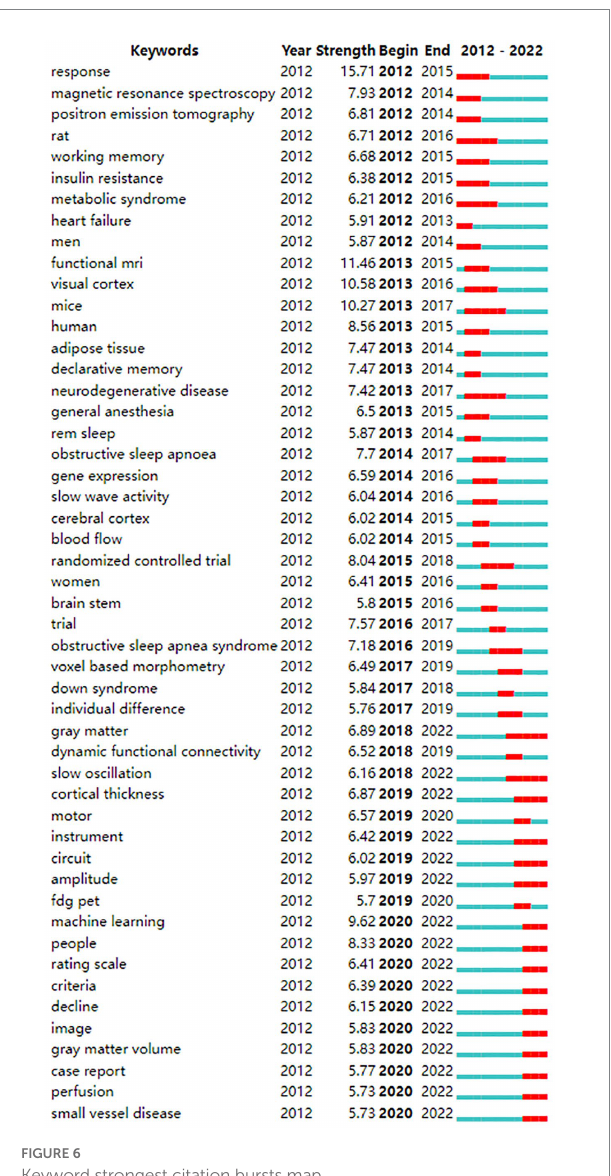
FIGURE 6 Keyword strongest citation bursts